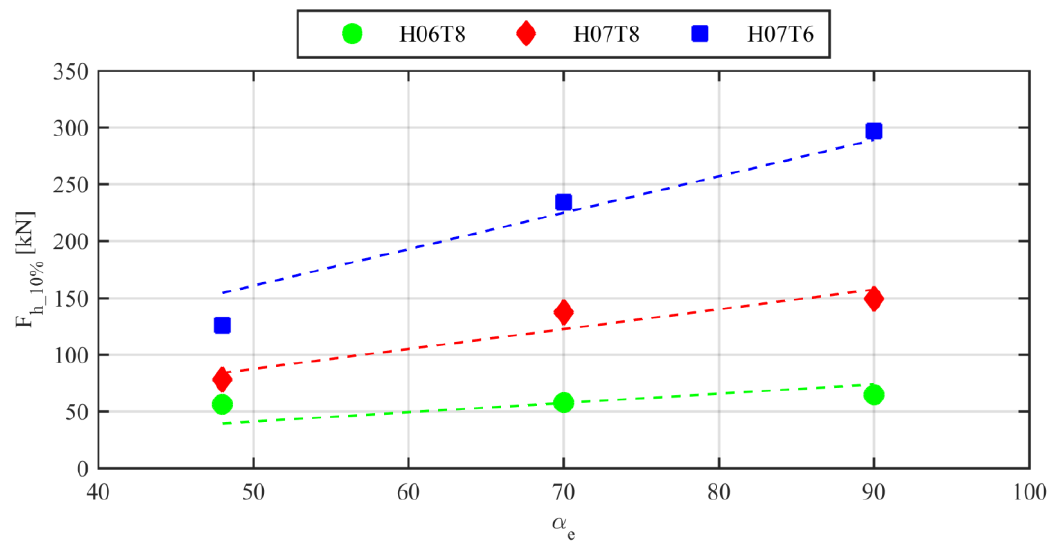
Figure 11. Mean of the 10% highest force peaks recorded for each test case over the extremity angle.